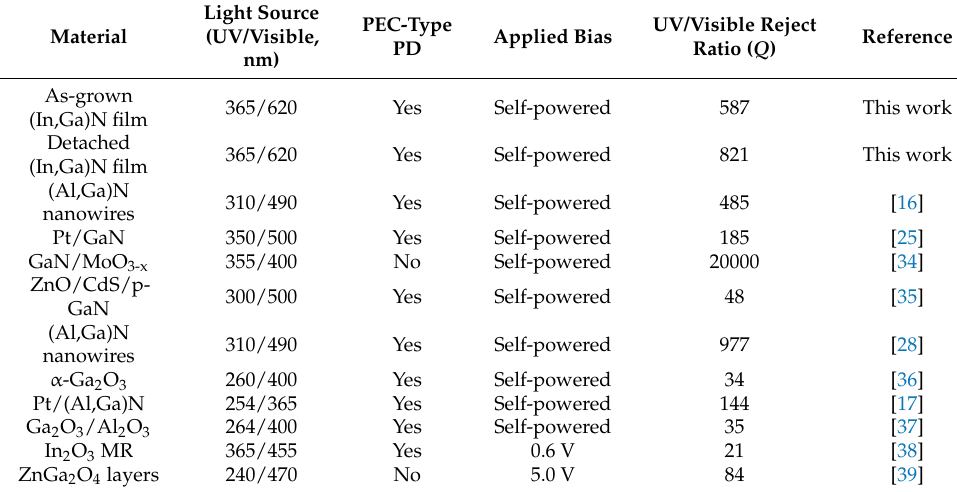
Table 1. Comparison between this work and other recently reported